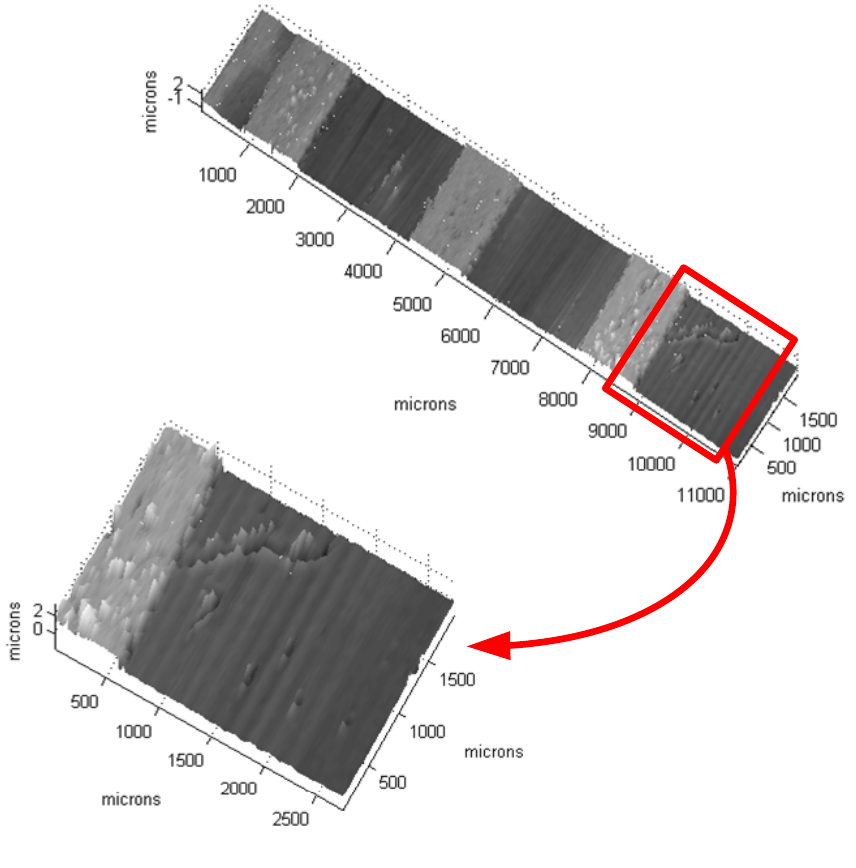
Figure 11. Detail of the 3-D surface scan of the test specimen. In addition to the one micron